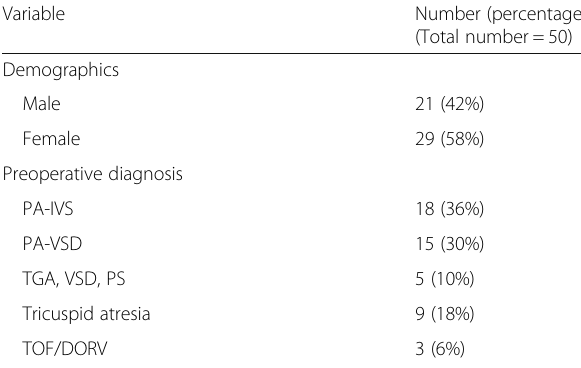
Table 1 Preoperative patient characteristics